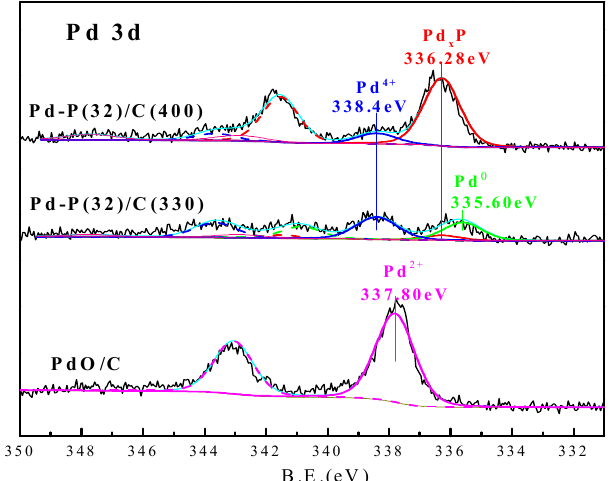
Table 1. Relative content and binding energy of Pd and P species of PdO/C, Pd-P(32)/C(330), and Pd- P(32)/C(400).